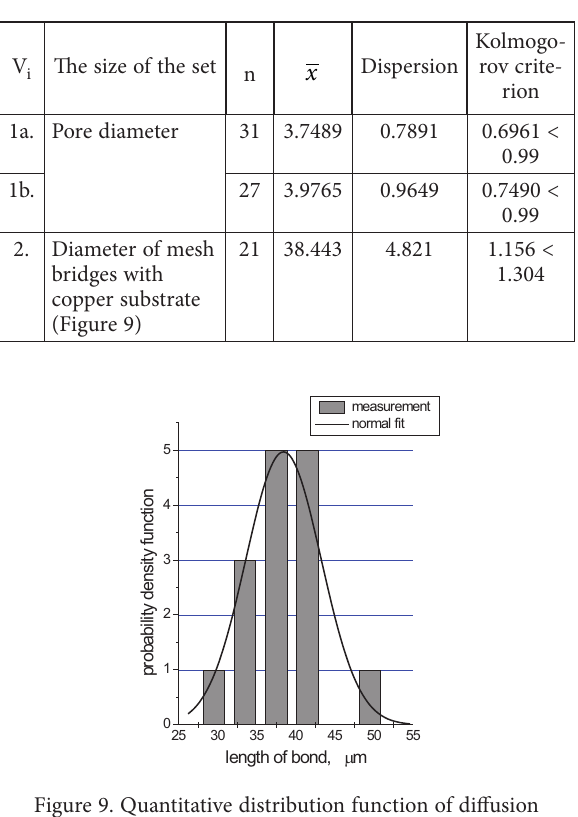
Figure 8. The effect of “hydrogen disease”: in structure (a) in the fiber (b) and the copper mesh (c) Table 4. Parameters of statistical processing (Paramonov, 1992) of fiber pore diameters in the i-volume (1), and the diameters of the length of copper mesh bridges (2)